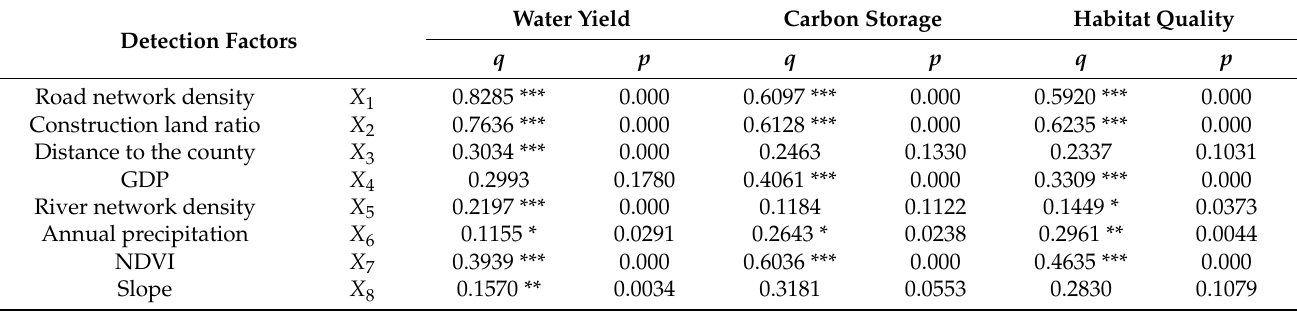
Table 4. The degree to which the drivers explain the differences in ecosystem services in